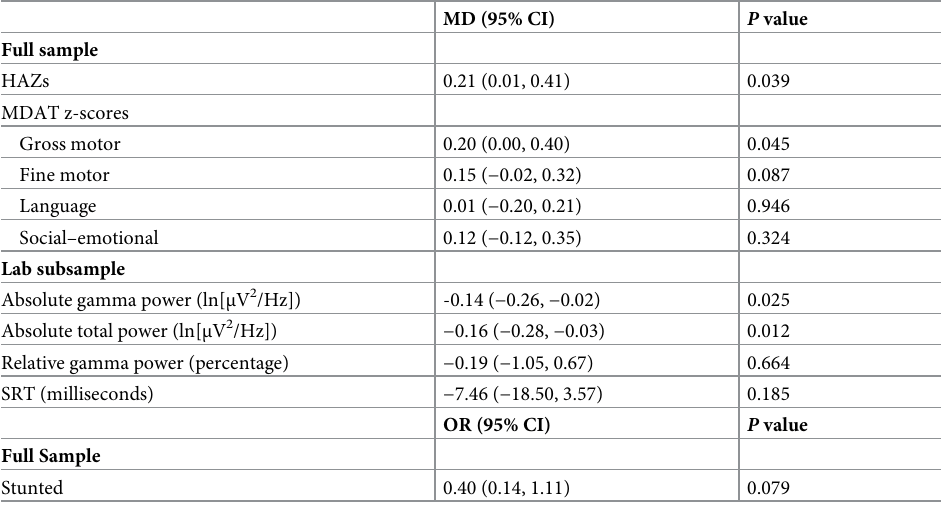
Table 4. Per-protocol analysis of impact on primary